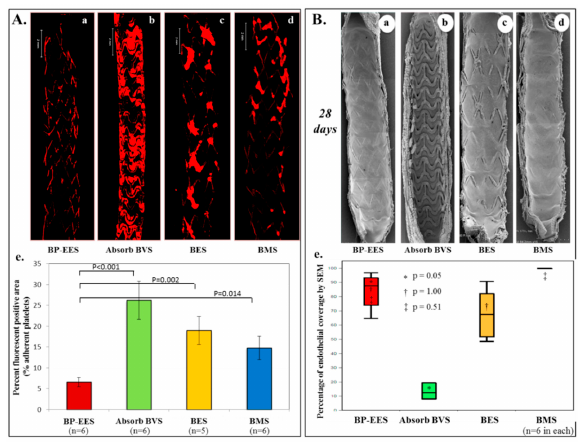
Figure 4. Acute thrombogenicity and delayed endothelial coverage of Absorb-BVS in experimental models. ( A ) Ex-vivo arteriovenous porcine shunt model. Representative images derived from confocal microscopy after 1 h in a swine ex-vivo shunt model. Platelets were stained with anti-CD61 and CD42b primary antibody and red-fluorescent secondary antibody. (a) Biodegradable polymer everolimus-eluting stent (BP-EES); (b) fully bioabsorbable everolimus-eluting scaffold